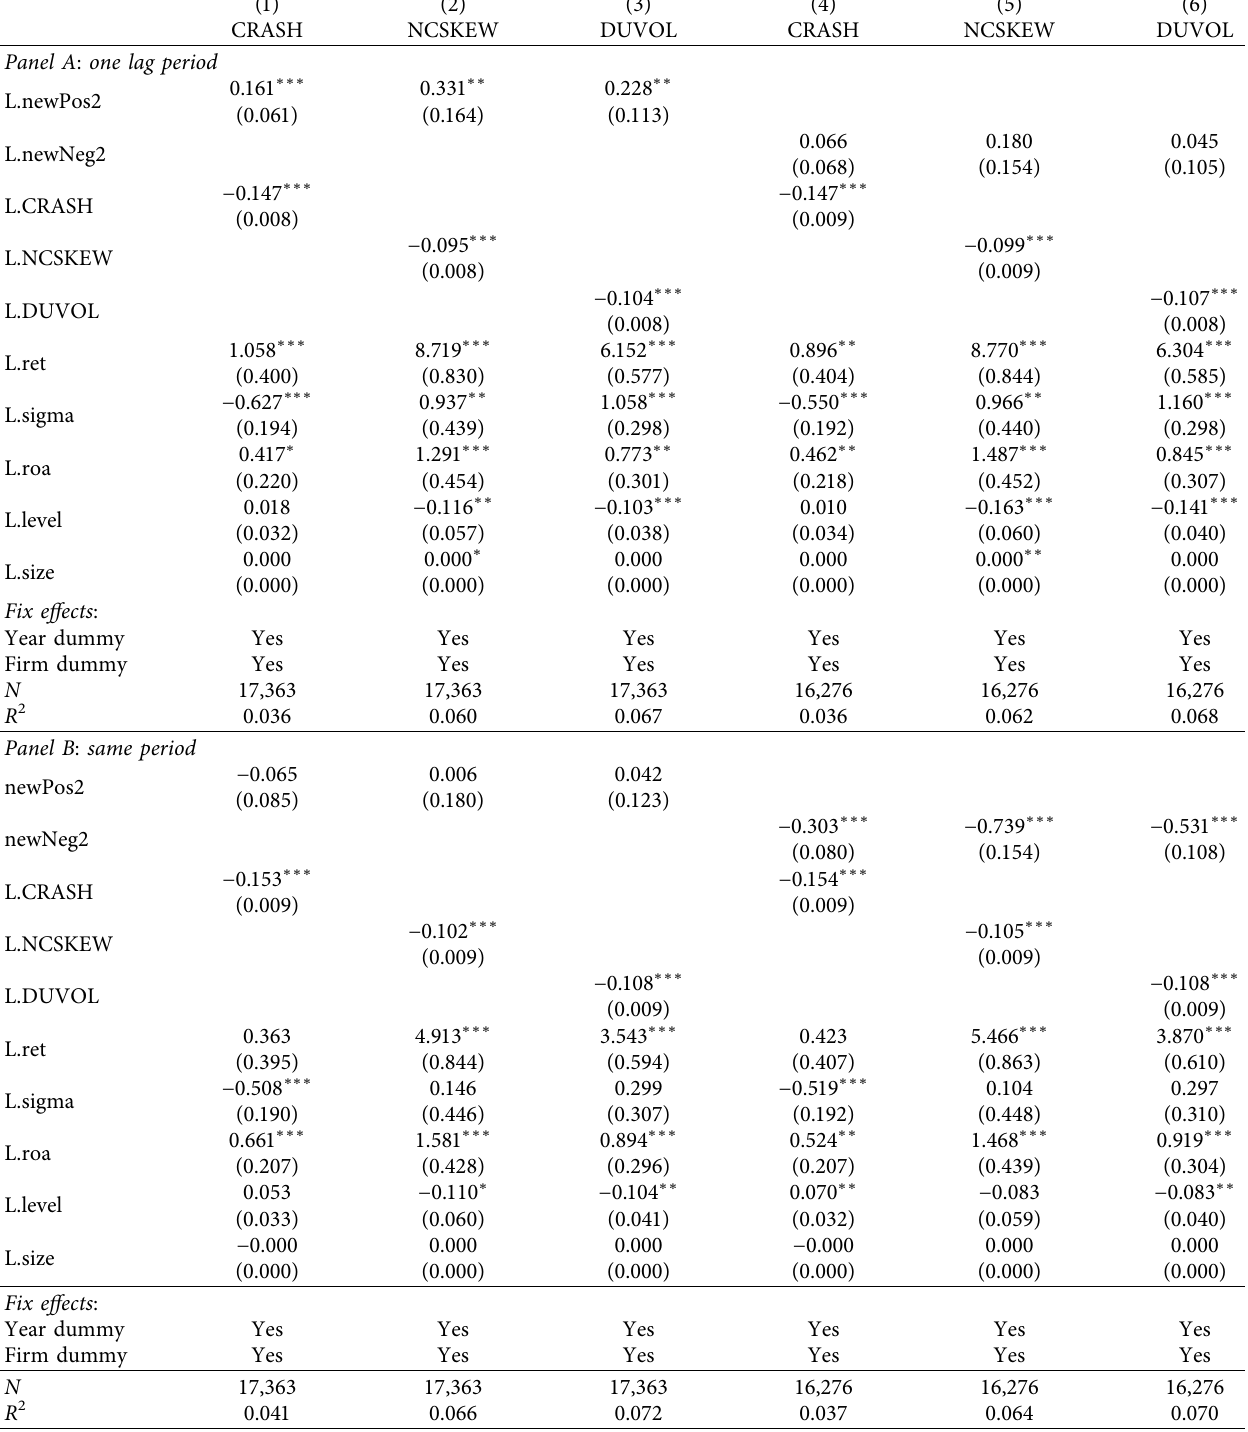
Table 15: Robust test: positive sentiment and negative sentiments of news